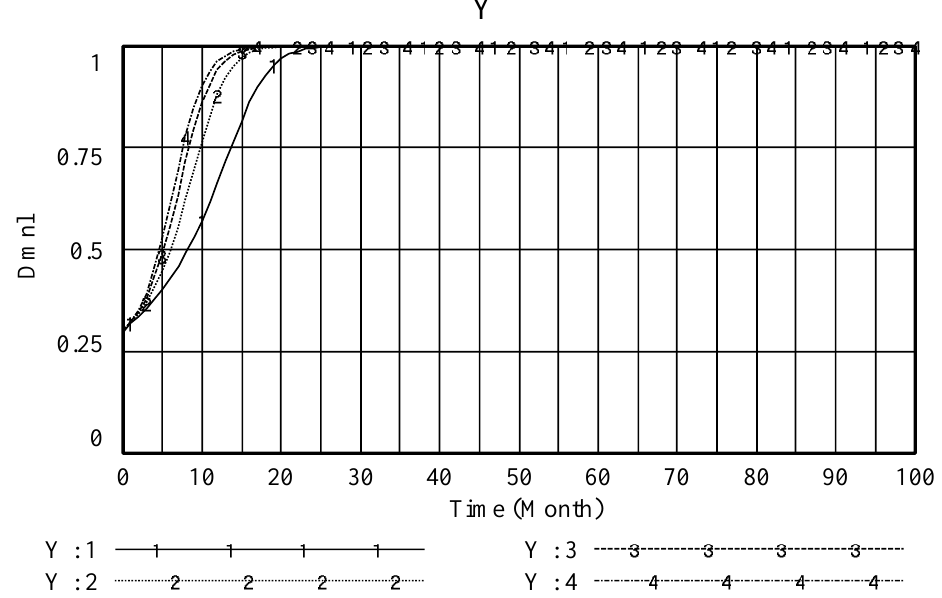
Figure 8. Simulation result of y when the amount of penalty, L changes.